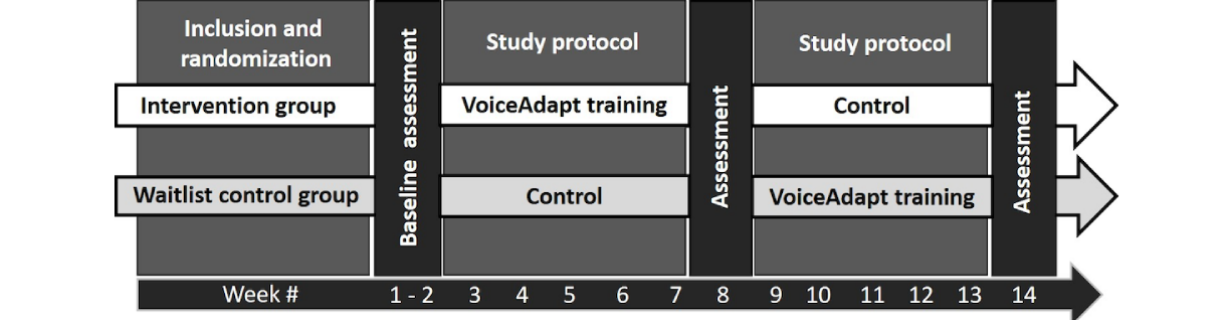
Figure 1. Schematic of the study